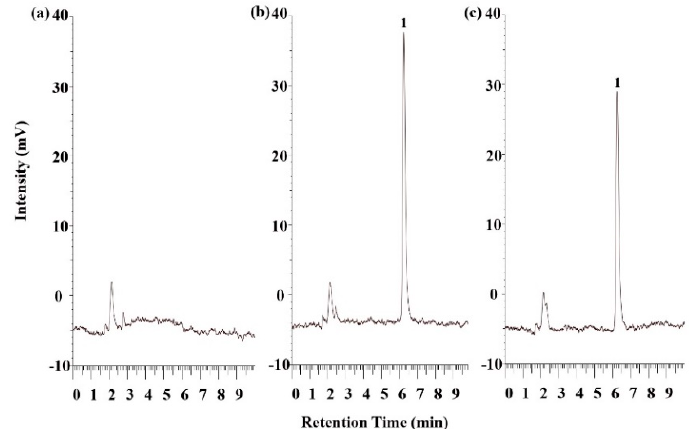
Figure 6. The HPLC-fluorescence chromatograms of ( a ) blank rat plasma; ( b ) blank rat plasma spiked with SSM (20 ng / mL); and ( c ) a rat plasma sample at 5 min after the oral administration of F10 (100 mg / kg). Peak identification: (1) SSM.